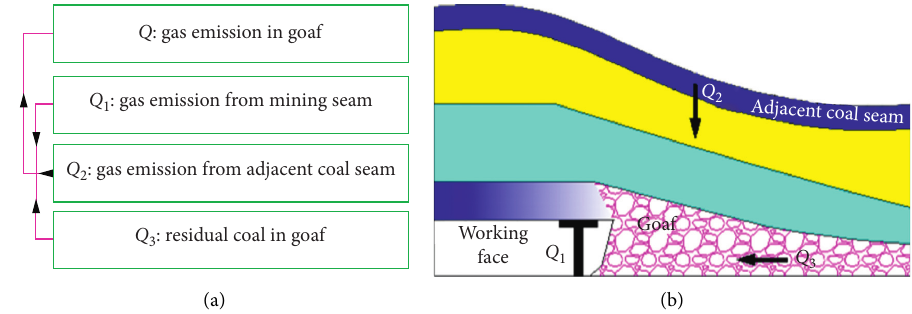
Figure 3: Gas source diagram of the working face. (a) Structure diagram of gas source in goaf. (b) Schematic diagram of gas source in